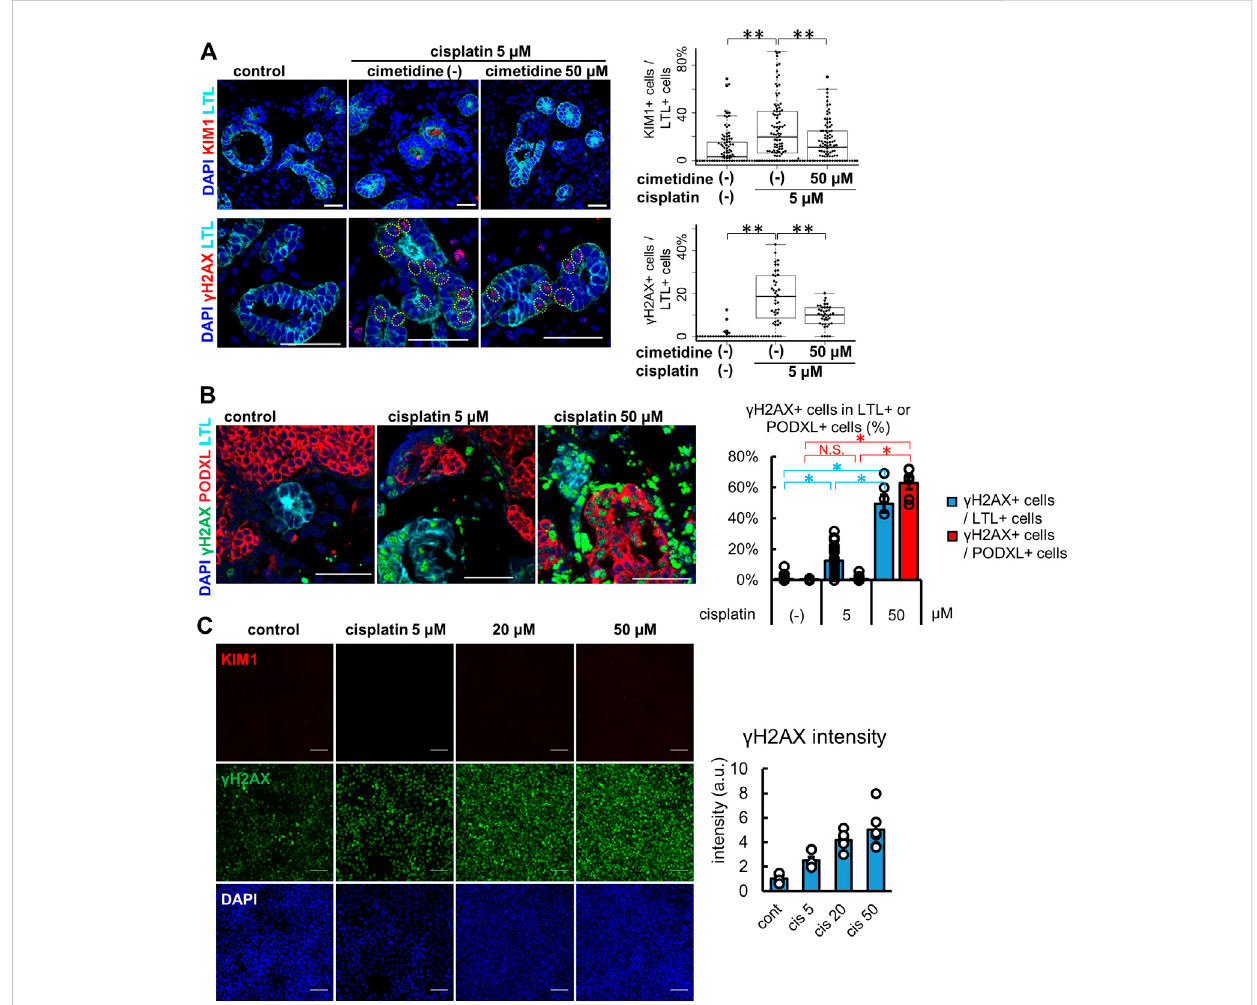
FIGURE 4 Injuryresponsestocisplatintreatmentinkidneyorganoidsandaproximaltubularcellline. (A) RepresentativeIFimagesofKIM1(red)and γ H2AX(red) in the organoids treated with 5 μ M cisplatin for 24 h. 50 μ M cimetidine attenuated cisplatin-induced proximal tubule injury. Experiments were repeated independently n =3timeswithsimilarresults.** p < 0.01.Scalebar:50 μ m. (B) IFof γ H2AXintheorganoidstreatedwithlowerorhigherdoses(5or50 μ M) of cisplatin. n = 6. Scale bar: 50 μ m * p < 0.05. (C) IF of γ H2AX and KIM1 in HKC-8 cells treated with cisplatin and quanti fi cation of γ H2AX intensity in arbitrary units (a.u.). n = 6. Scale bar: 100 μ